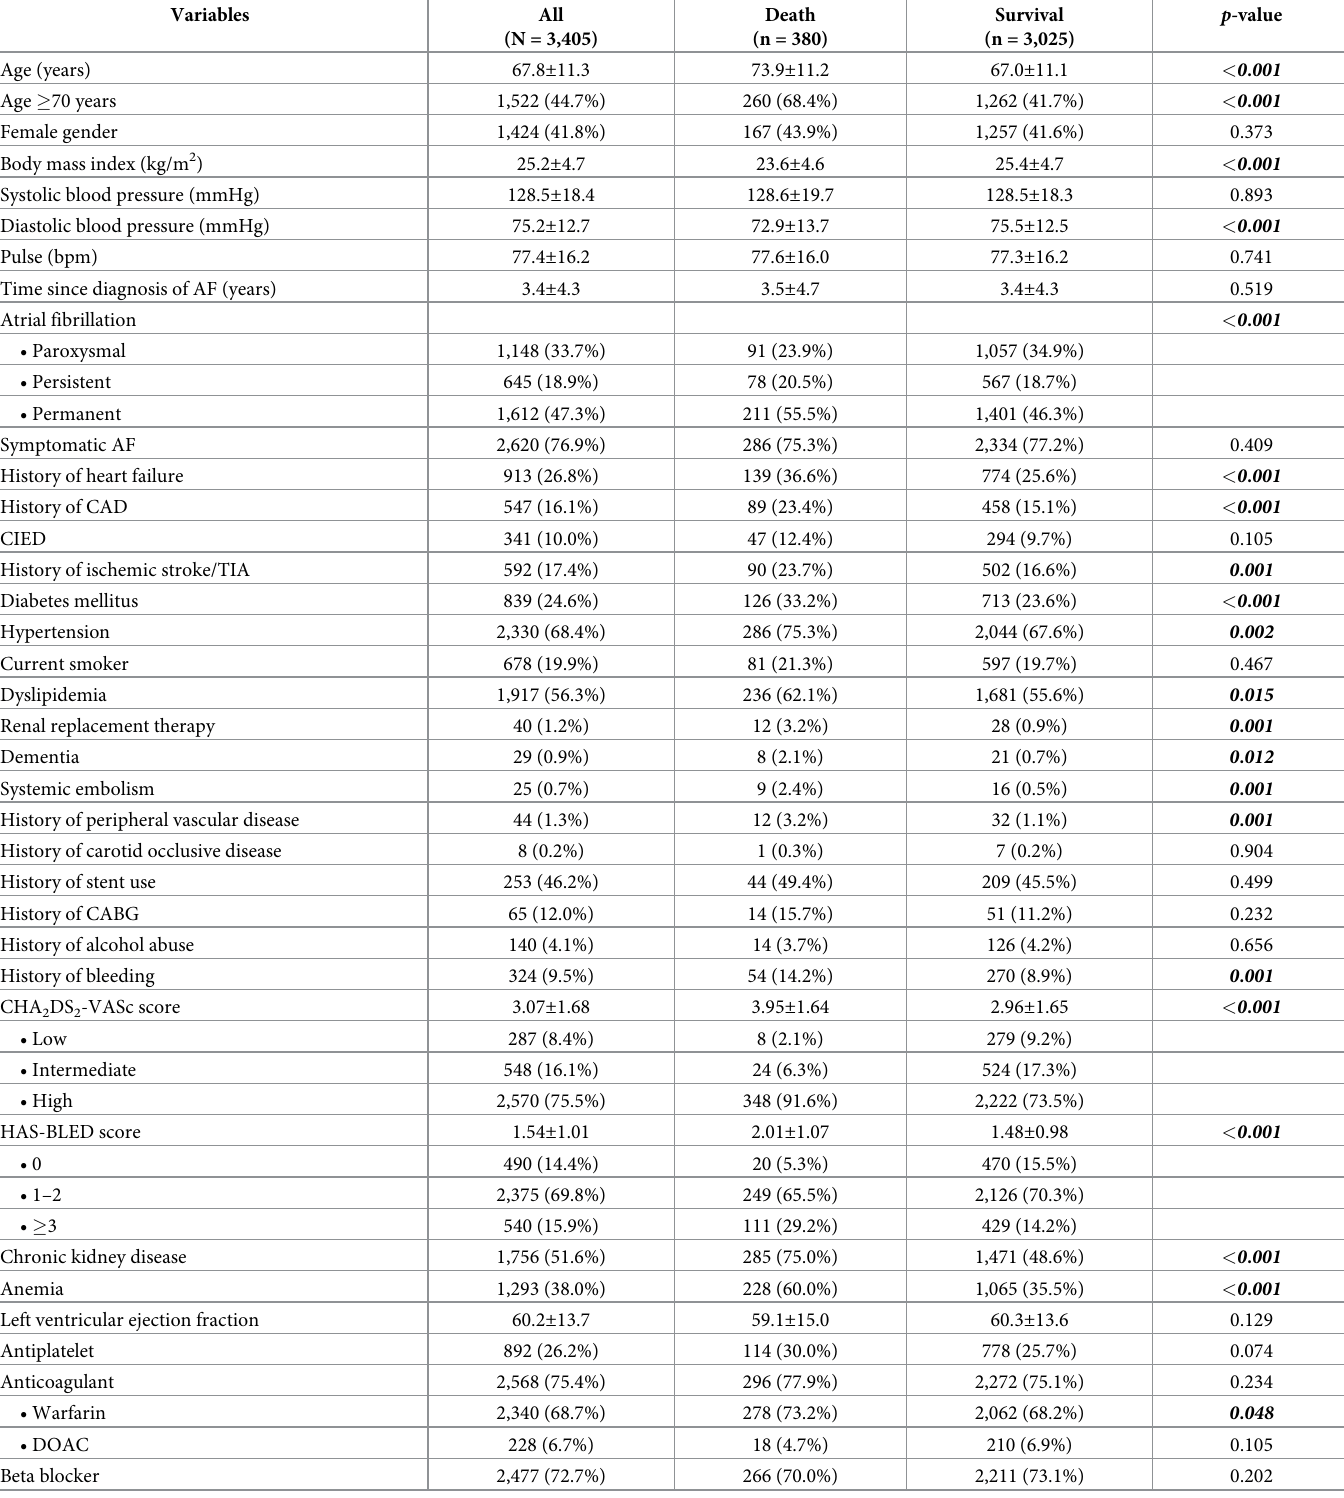
Table 1. Baseline demographic and clinical characteristics of all patients, and compared between those who died and those who survived during